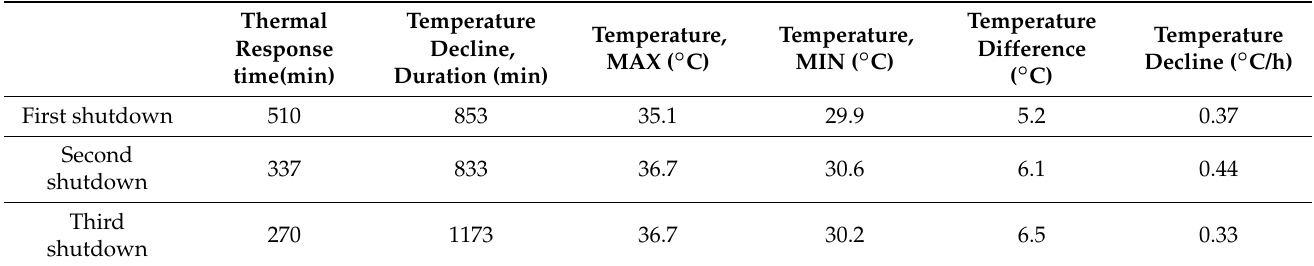
Figure 15. Three shutdowns showing temperature difference versus duration of temperature decline for the shutdown valve. With the present field test set-up, the drainage valve measurements could be used to capture the temperature decline throughout the pipe section (i.e., B–D). However, with